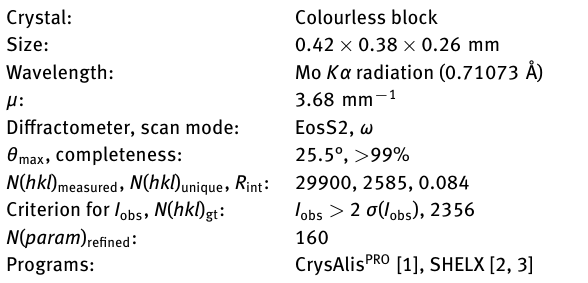
Table 1: Data collection and